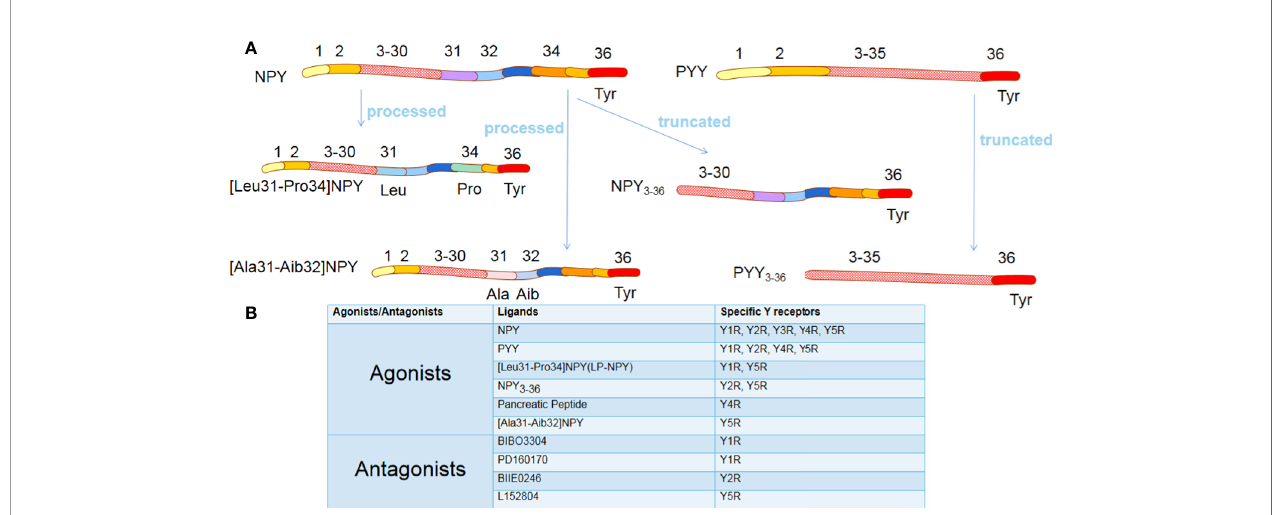
FIGURE 1 | The agonists and antagonists of Y receptors. (A) NPY and PYY are processed into different ligands. Although these ligands have a similar amino acid composition to NPY/PYY, when the two amino acid residues of NPY/PYY are replaced or truncated, it signi fi cantly changes their af fi nity for different Y receptor subtypes. (B) The most commonly used agonists and antagonists speci fi c for different Y receptor subtypes. NPY, neuropeptide Y; PYY, peptide YY; Tyr, Tyrosine; Leu, Leucine; Pro, Proline; Ala, Alanine; Aib, 2-aminoisobutyric